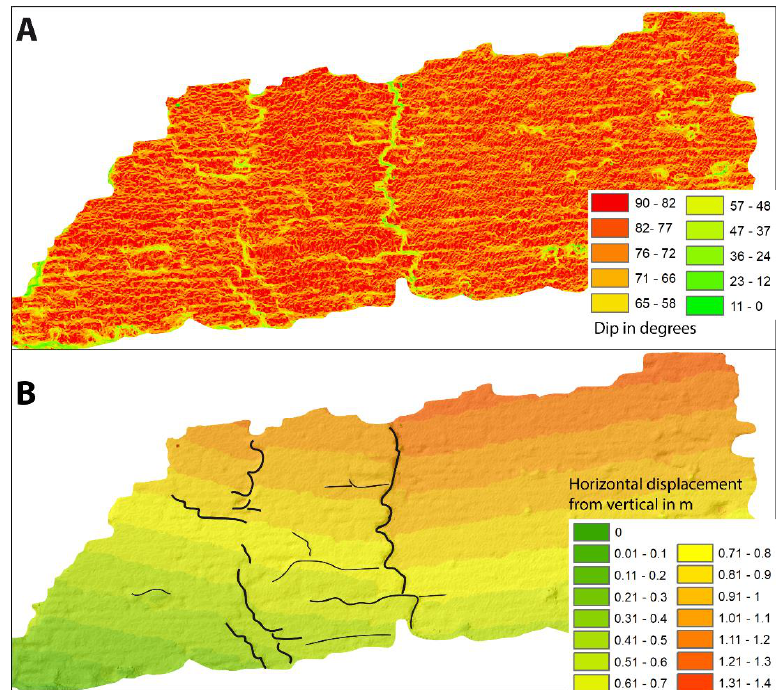
Figure 7. ( A ) Dip in degrees of the most northeastern part of the east side of the city wall (for loca- tion, see Figure 5A). ( B ) Interpretation of the fractures (faults) accumulating fragile deformation and delimitating sectors with similar tilting in the city wall over the hypsometric distribution of the horizontal displacement from vertical in the city wall, characterizing the different tilted sector in the city wall. Models A and B were obtained from a DEM with 1 mm of pixel resolution.